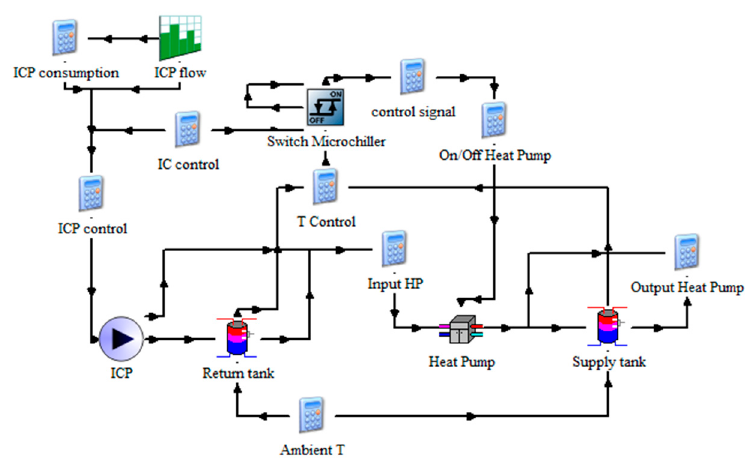
Figure 5. Heat Pump and other IC components in TRNSYS.